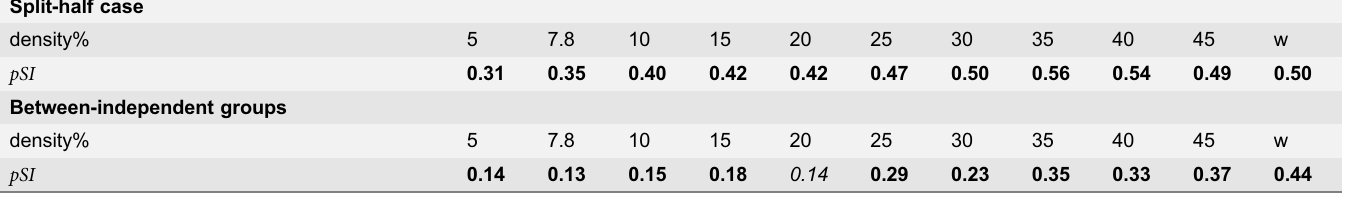
A network is dependent on the choice of the measure of connectivity between different brain regions. Many groups investigating functional networks in the human brain use the Pearson correlation coefficient [8, 50, 66]. Other similarity measures have also been used, including the correlation between wavelet components [5, 10, 67] and mutual information [44]. However, constructing a network by correlation or mutual information does not necessarily imply that the functional connection between two nodes is direct. The distinction between direct and indirect functional relationships between areas is very important in terms of correctly estimating the network. Hence, partial correlation became a hot topic in recent years (e.g.[43, 68, 69]). Partial correlation provides a convenient summary of conditional independence and turns out to be an effective way to model the connectivity [44]. In our work, partial correlations are used to remove mutual dependencies on common influences from other brain areas. By conditioning the dependencies between two nodes on other nodes, the functional connectivity (i.e. partial correlation) reflects a quantity that is more closely related to direct interaction, taking the analysis of functional connectivity closer to the characterization of functional interactions in terms of effective connectivity. It is data-driven in the sense that, unlike existing methods such as structural equation modelling (SEM) and dynamic causal modelling (DCM), it does not require any prior information regarding functional interactions.